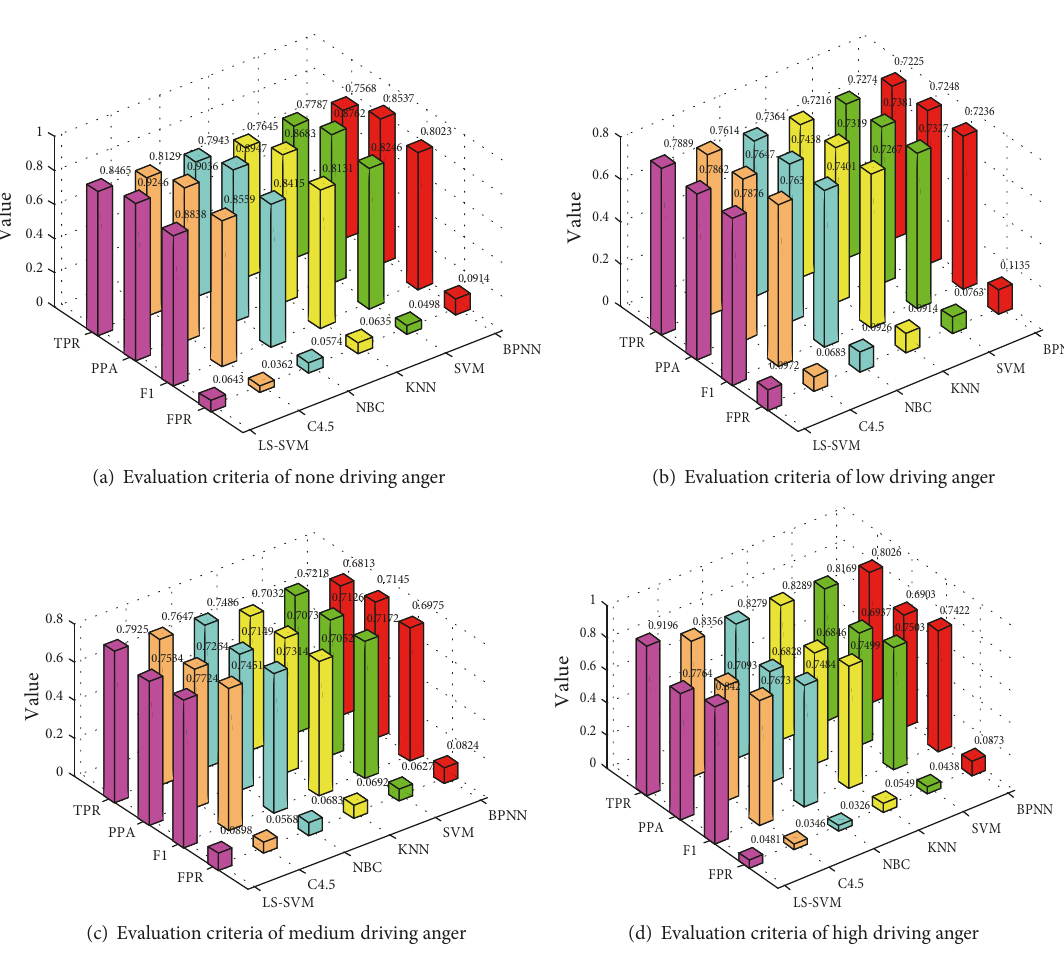
Figure 9: The classification performance of six models for four driving anger